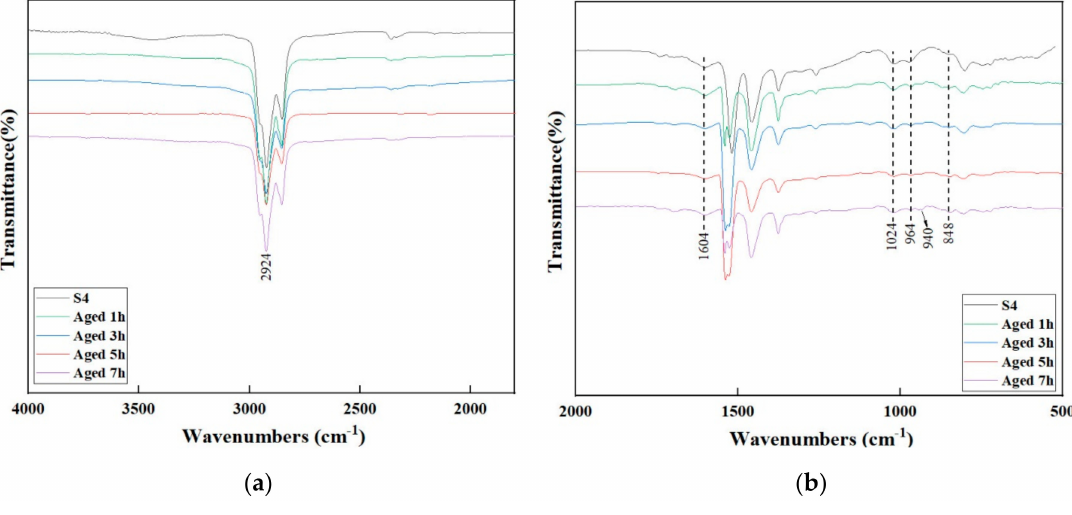
Figure 6. FTIR spectra of S4 at di ff erent aging times. ( a ) 4000 to 1500 cm − 1 ; ( b ) 1800 to 600 cm − 1 .